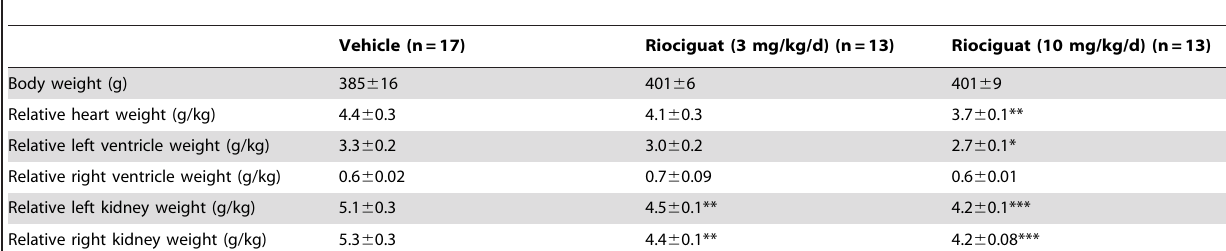
Table 1. Organ weights in the vehicle- and riociguat-treated Dahl/ss rats maintained on a high-salt diet.